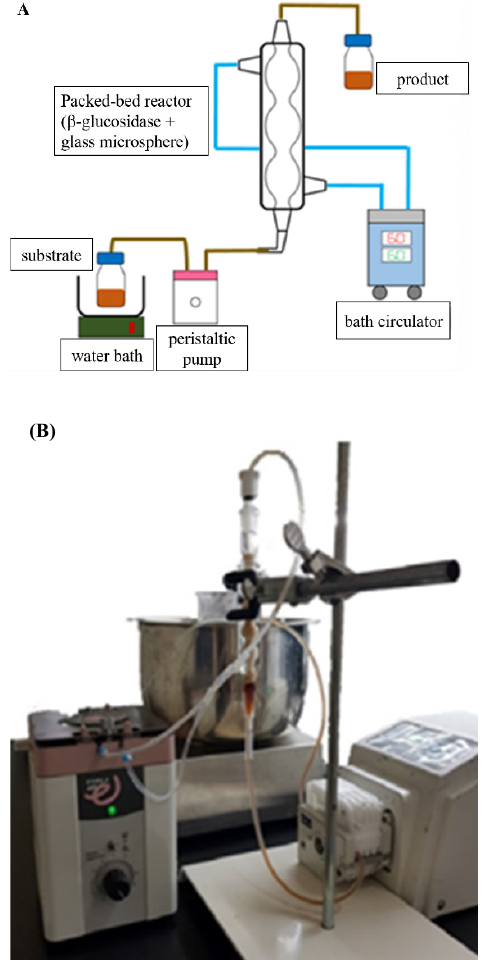
Figure 5. The design of ( A ) and the real ( B ) immobilized β‐ glucosidase bioreactor. The inner layer of the column (9 mL) with 2 g β‐ glucosidase immobilized glass microspheres and the outer layer full, with constant temperature water to control the reaction temperature. The sample injected into the column from the bottom through a pump and collected by a bottle with a constant temperature water tank for the termination of the catalysis.